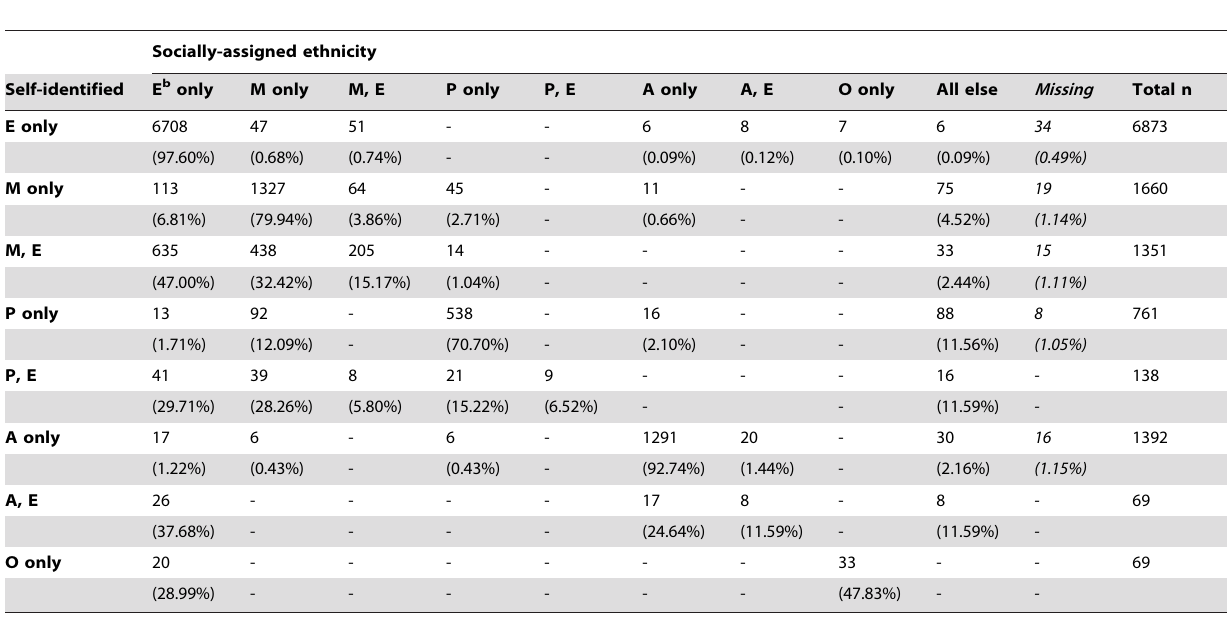
Table 1. Cross-tabulation of self-identified ethnicity versus socially-assigned ethnicity a (unweighted frequencies and percentages).